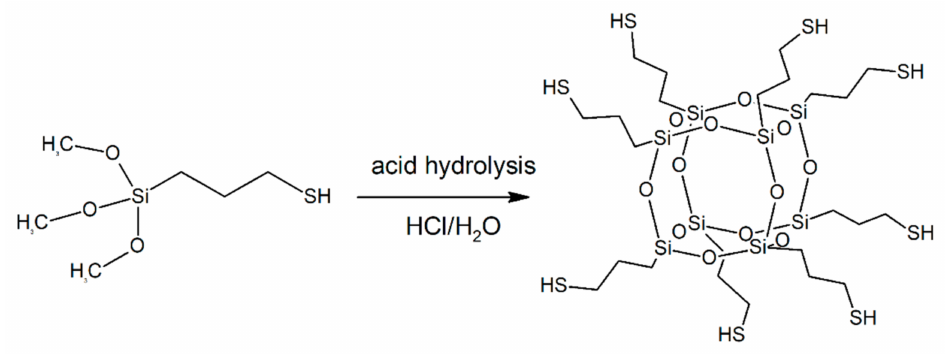
Figure 3. Cu-chelating POSS synthesis and